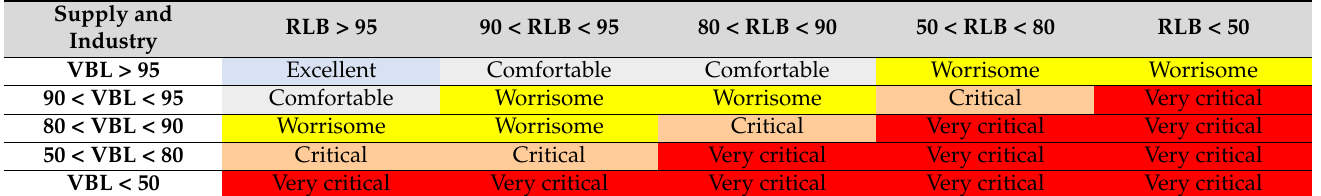
Table 2. Classification—human supply and